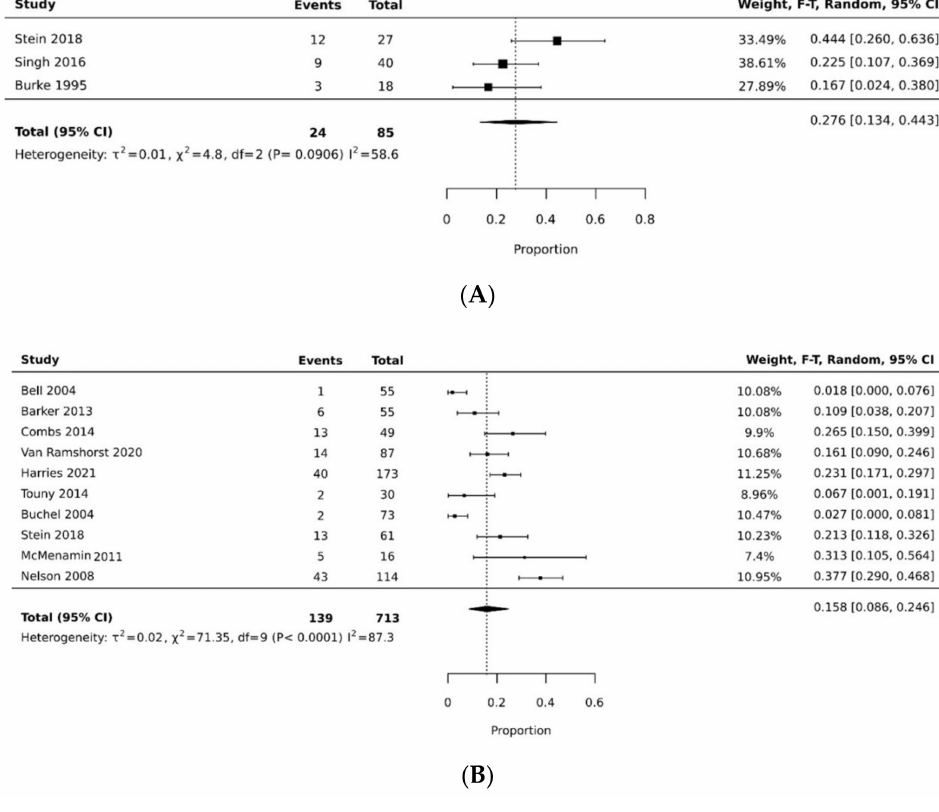
Figure 5. ( A ) Forest plot for recipient site dehiscence for gracilis [21,26,38]. ( B ) Forest plot for recipient site dehiscence for VRAM